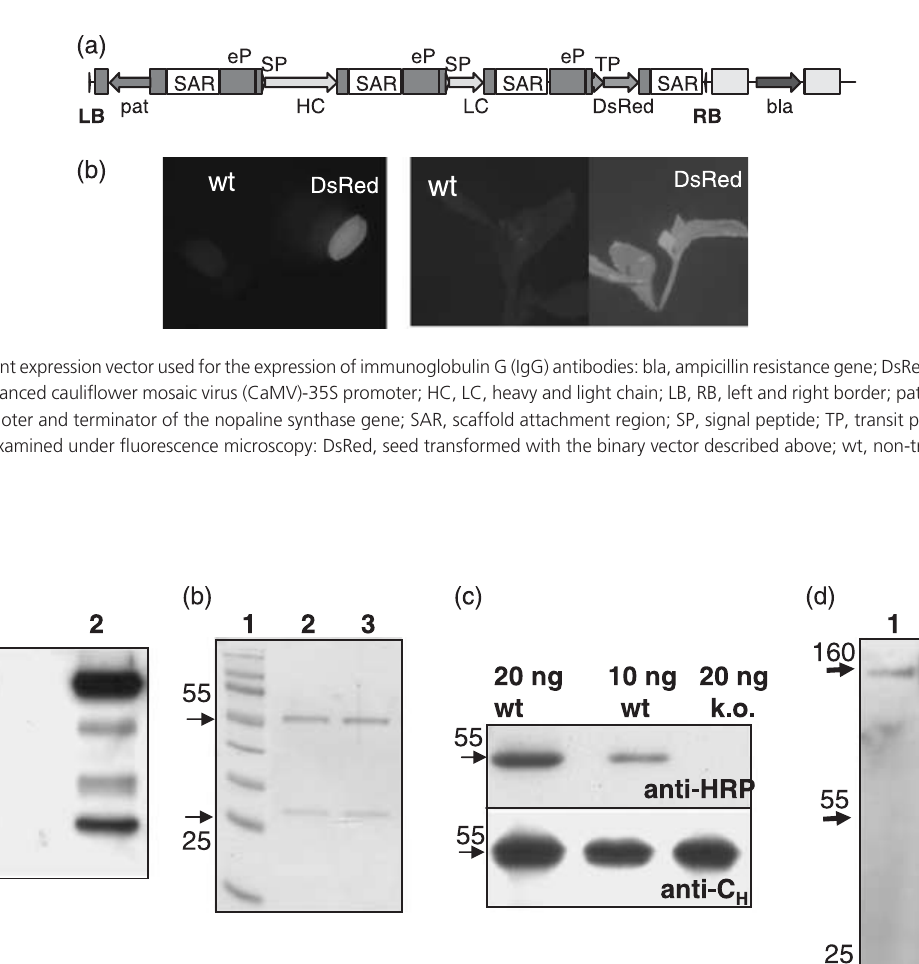
further bands, degradation products or impaired heavy or (Figure 3c). As expected, a single band with a molecular mass light chains in PAGE under native conditions were visible, of about 55 kDa was detected in all samples using C indicating the purity and high rate of antibody assembly. The antibodies. By contrast, no signal was obtained in XT/FT k.o.- weak extra bands between C and C of 2G12 that were derived IgG using anti-HRP anti-serum, indicating the absence H L visible when TSP extracts were used for immunoblotting of immunogenic glycan epitopes. (Figure 3a) may represent degradation products from C The expression level of 2G12 in A. thaliana wt and k.o. lines H within the plant cell; however, they disappeared completely varied between 0.2 and 0.05% of TSP in young plants (up to after 2G12 purification. In addition, purified CHO- and plant- the six-leaf stage). As plants aged, the expression level dropped derived IgGs were subjected to immunoblotting using anti- below 0.05% TSP. 2G12-expressing plants, both wt and k.o. bodies that recognized C - and plant-specific glycan epitopes lines, were normal and viable and did not show any obvious H [anti-horseradish peroxidase (anti-HRP) antibody], respectively morphological phenotype under standard growth conditions.